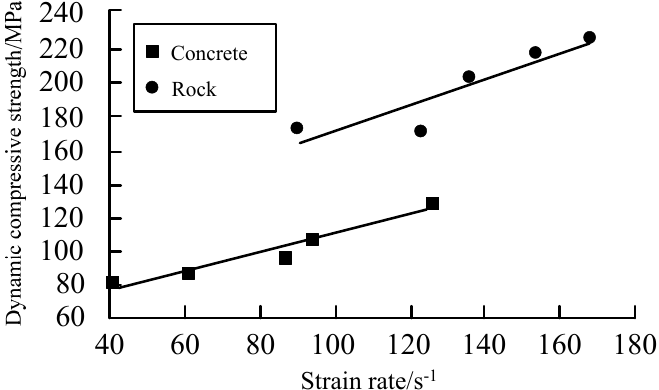
Figure 3: Correlation between dynamic compressive strength and strain